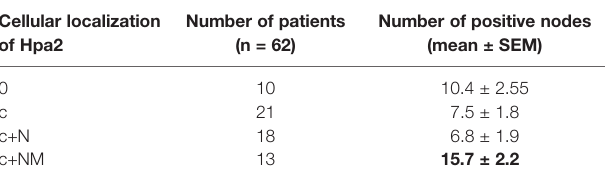
TABLE 2 | NM Hpa2 correlates with increased number of positive nodes in metastatic PTC (group C). Cellular localization Number of patients of Hpa2 (n =